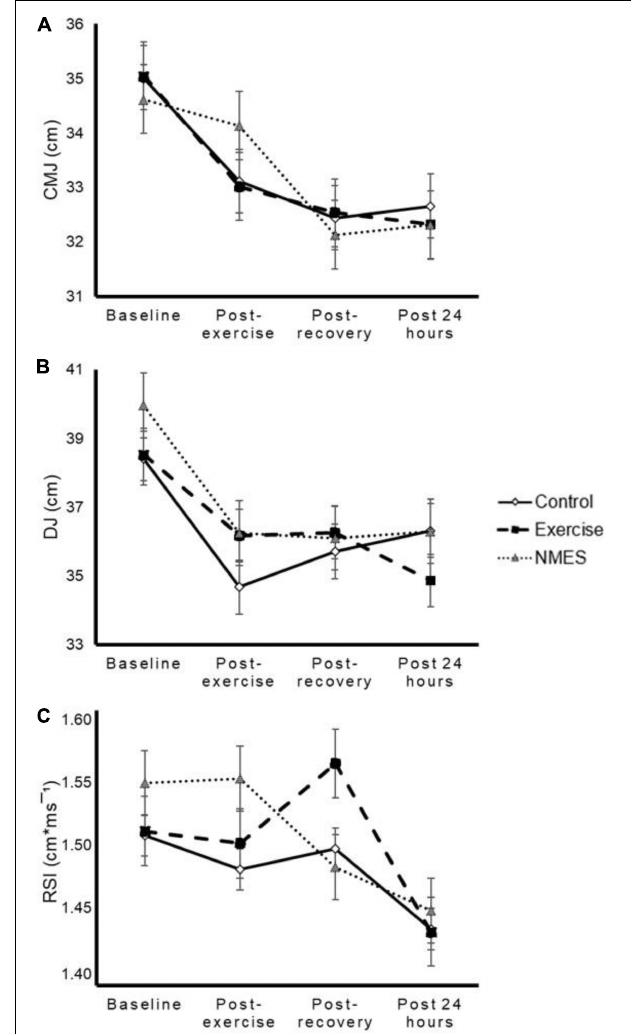
FIGURE 4 | Effects of low-intensity exercise (Exercise), neuromuscular electrical stimulation (NMES), or total rest (Control) on countermovement jump (CMJ, panel A ), drop jump (DJ, panel B ), and reactive strength index (RSI, panel C ). No significant time by condition interaction effect was found ( p = 0.388, p = 0.296, and p = 0.390,